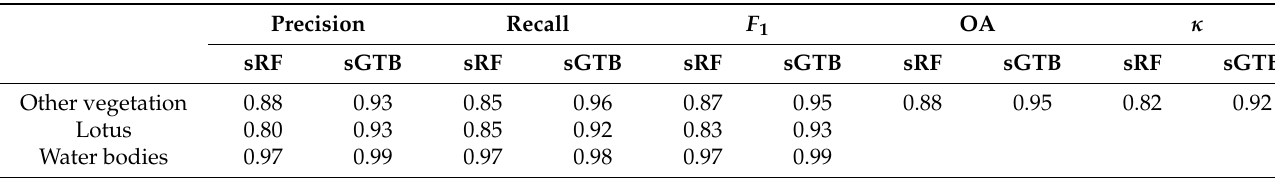
Table 5. Accuracy assessment of lotus mapping.